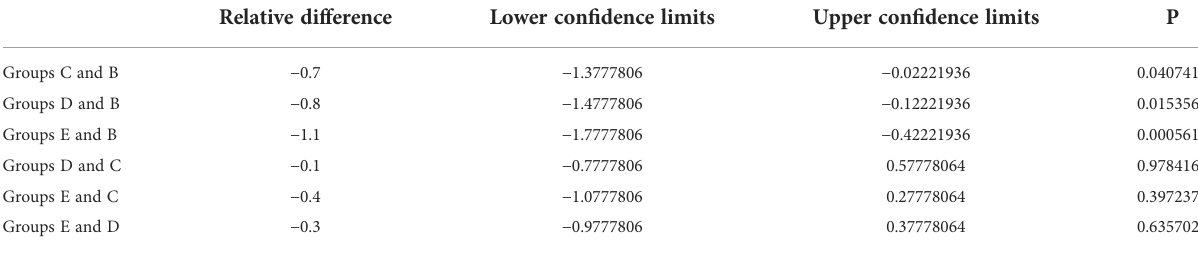
TABLE 4 Results of pairwise comparison of in fi ltration score among